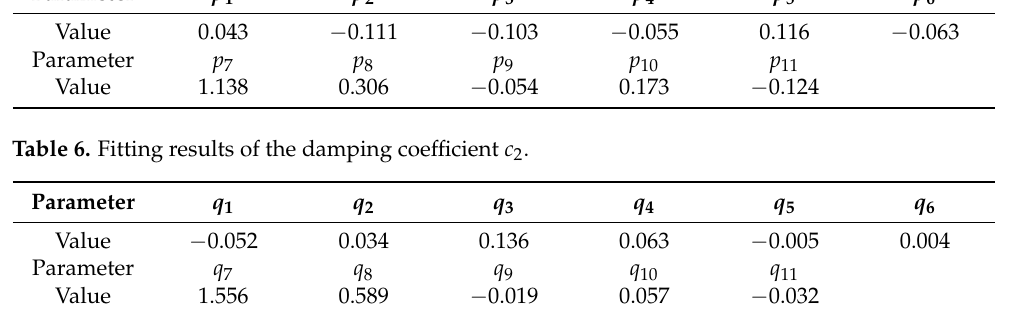
Table 5. Fitting results of the damping coefficient c 1 .